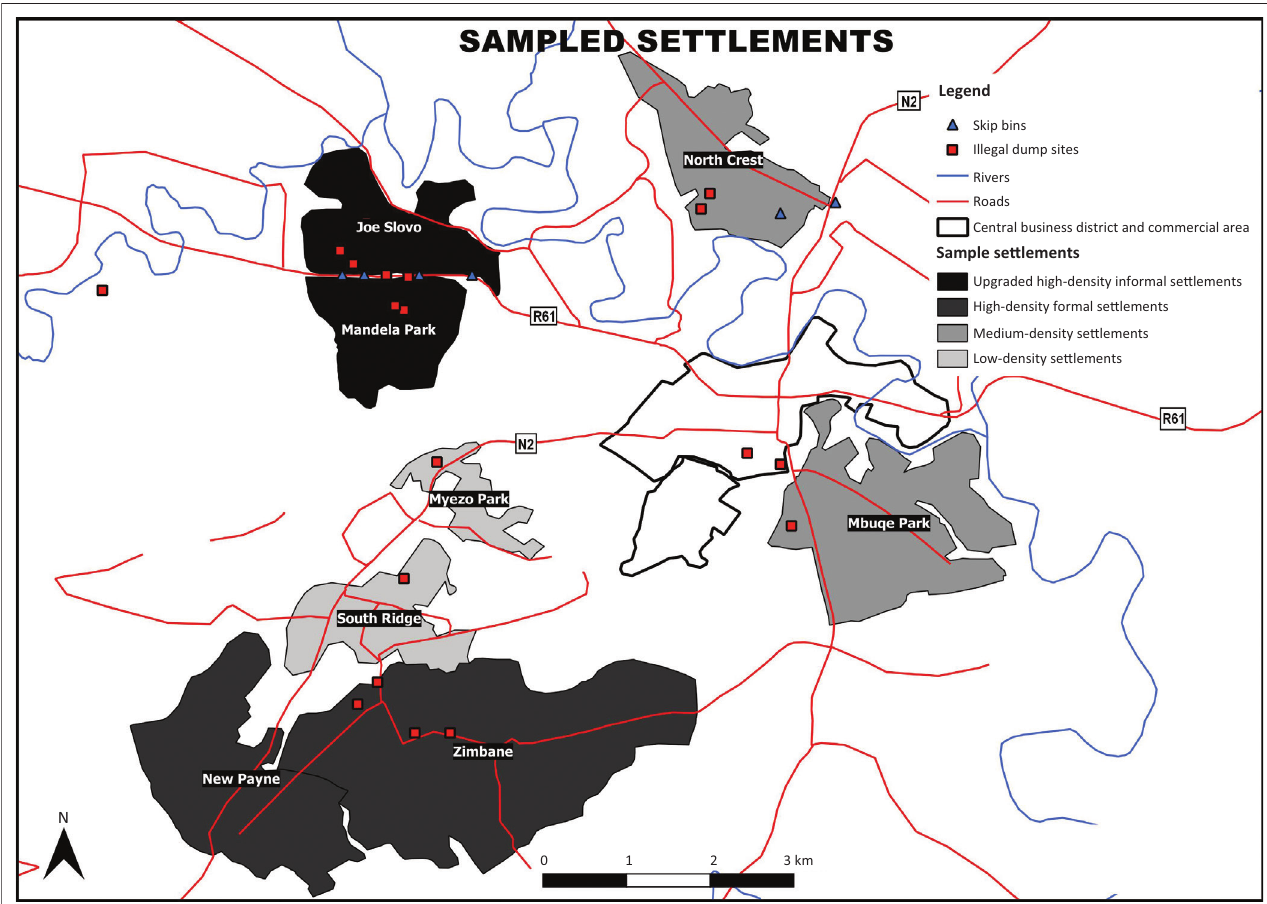
FIGURE 2: Map showing the investigated communities in